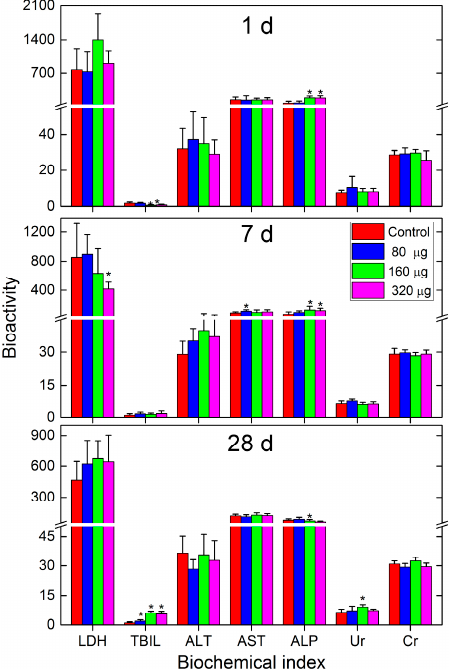
Figure 3. Serum biochemical parameters of the mice exposed to CNSI post intravenous exposure. Data represent means ± SD ( n = 6). * p < 0.05 compared with the control group.